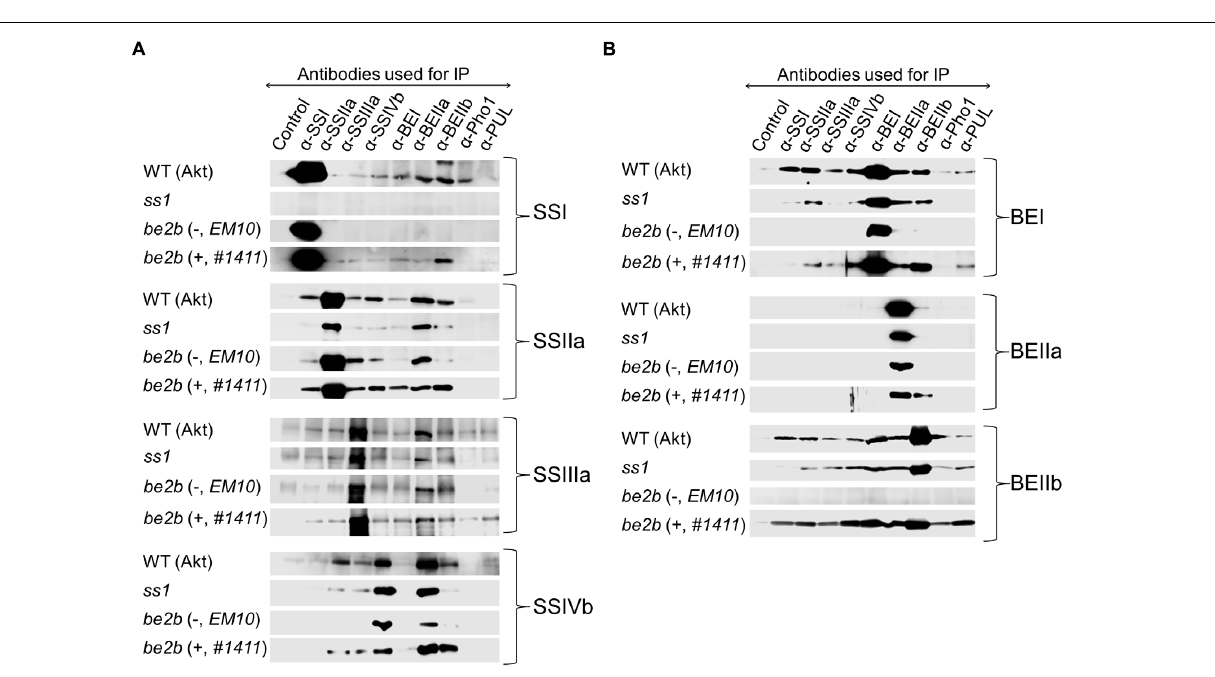
FIGURE 4 | Co-immunoprecipitation of proteins from the ss1 and be2b mutants. (–), line EM10 , which lacks BEIIb protein; (+), line # 1411 , which produces inactive BEIIb protein. The wild-type (WT) is Akt. Soluble proteins extracted from developing seeds were incubated with the indicated isozyme-specific antibodies and protein A sepharose. After washing, the captured proteins were analyzed by western blotting. Control experiment was performed using pre-immune antisera. (A) Western blotting of SS isozymes. (B) Western blotting of BE isozymes. The images are representative of at least